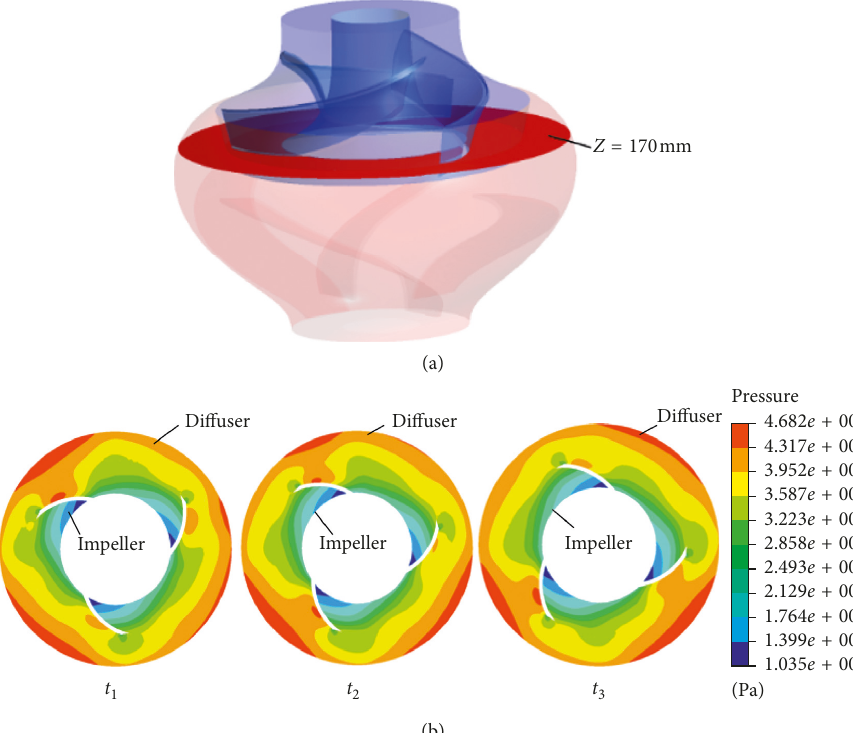
Figure 8: Static pressure distribution at (a) z � 170 mm (this section is the position of the impeller outlet and the diffuser inlet) and (b) different time